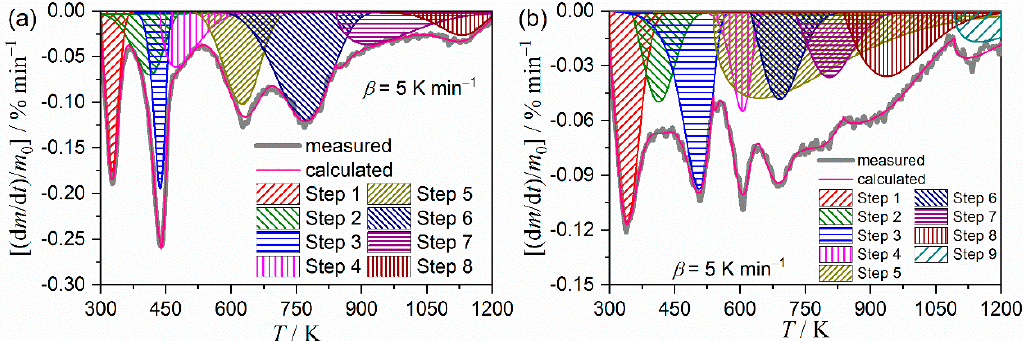
Figure 10. Typical results of MDA for the multistep thermal decomposition of MB samples: ( a ) P-MB and ( b ) S-MB.